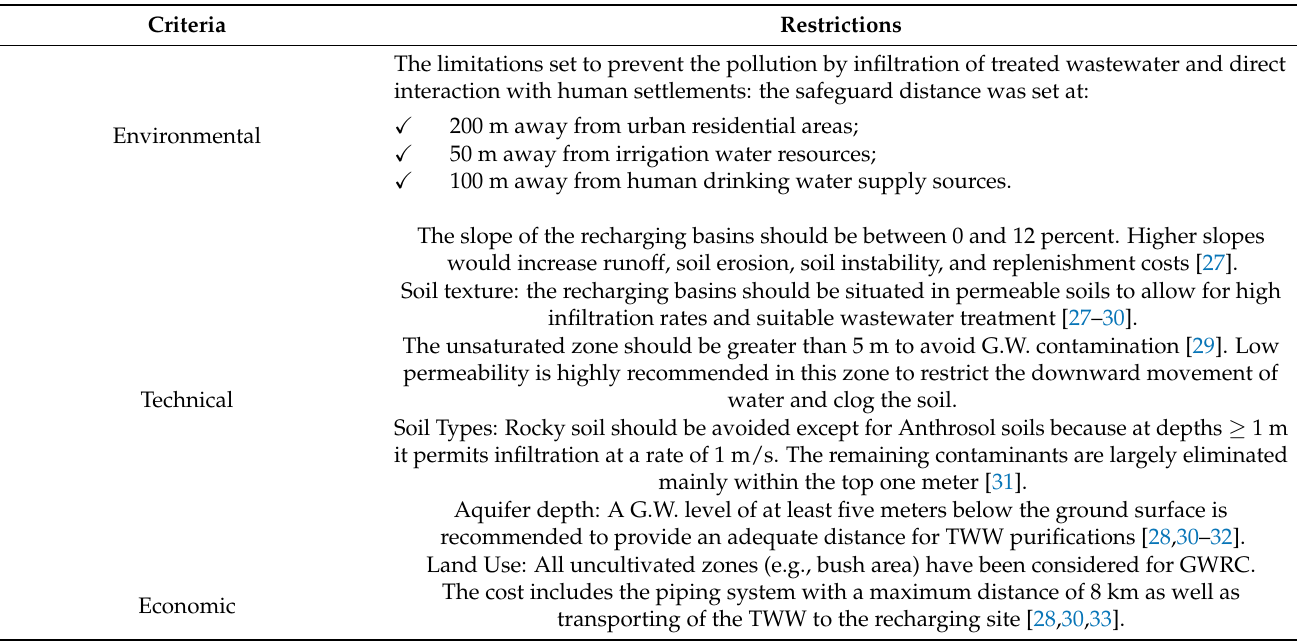
Table 1. Environmental, technical, and economic criteria used for the selection of the appropriate locations for GWRC (adapted from